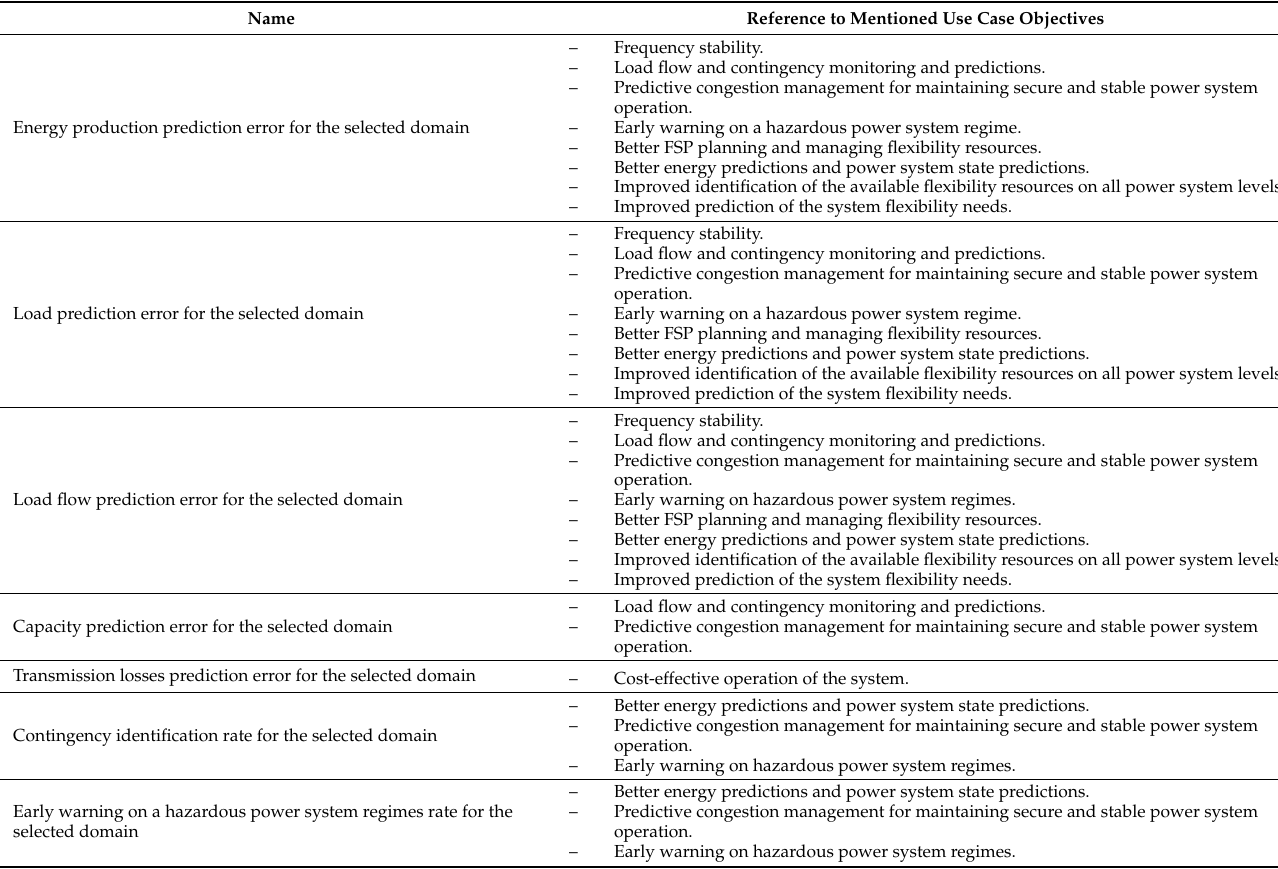
Table 8. Key performance indicators for SUC